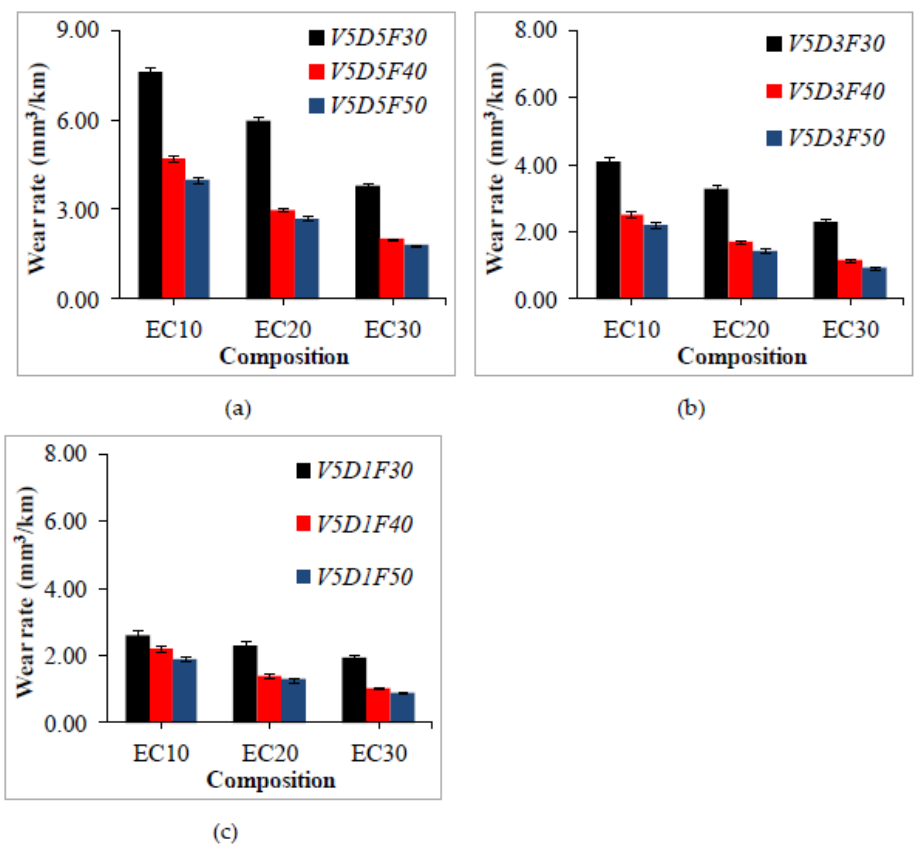
Figure 5. Experimentally measured wear rate at different sliding distances ( a ) 5 km ( b ) 3 km and ( c ) 1 km.